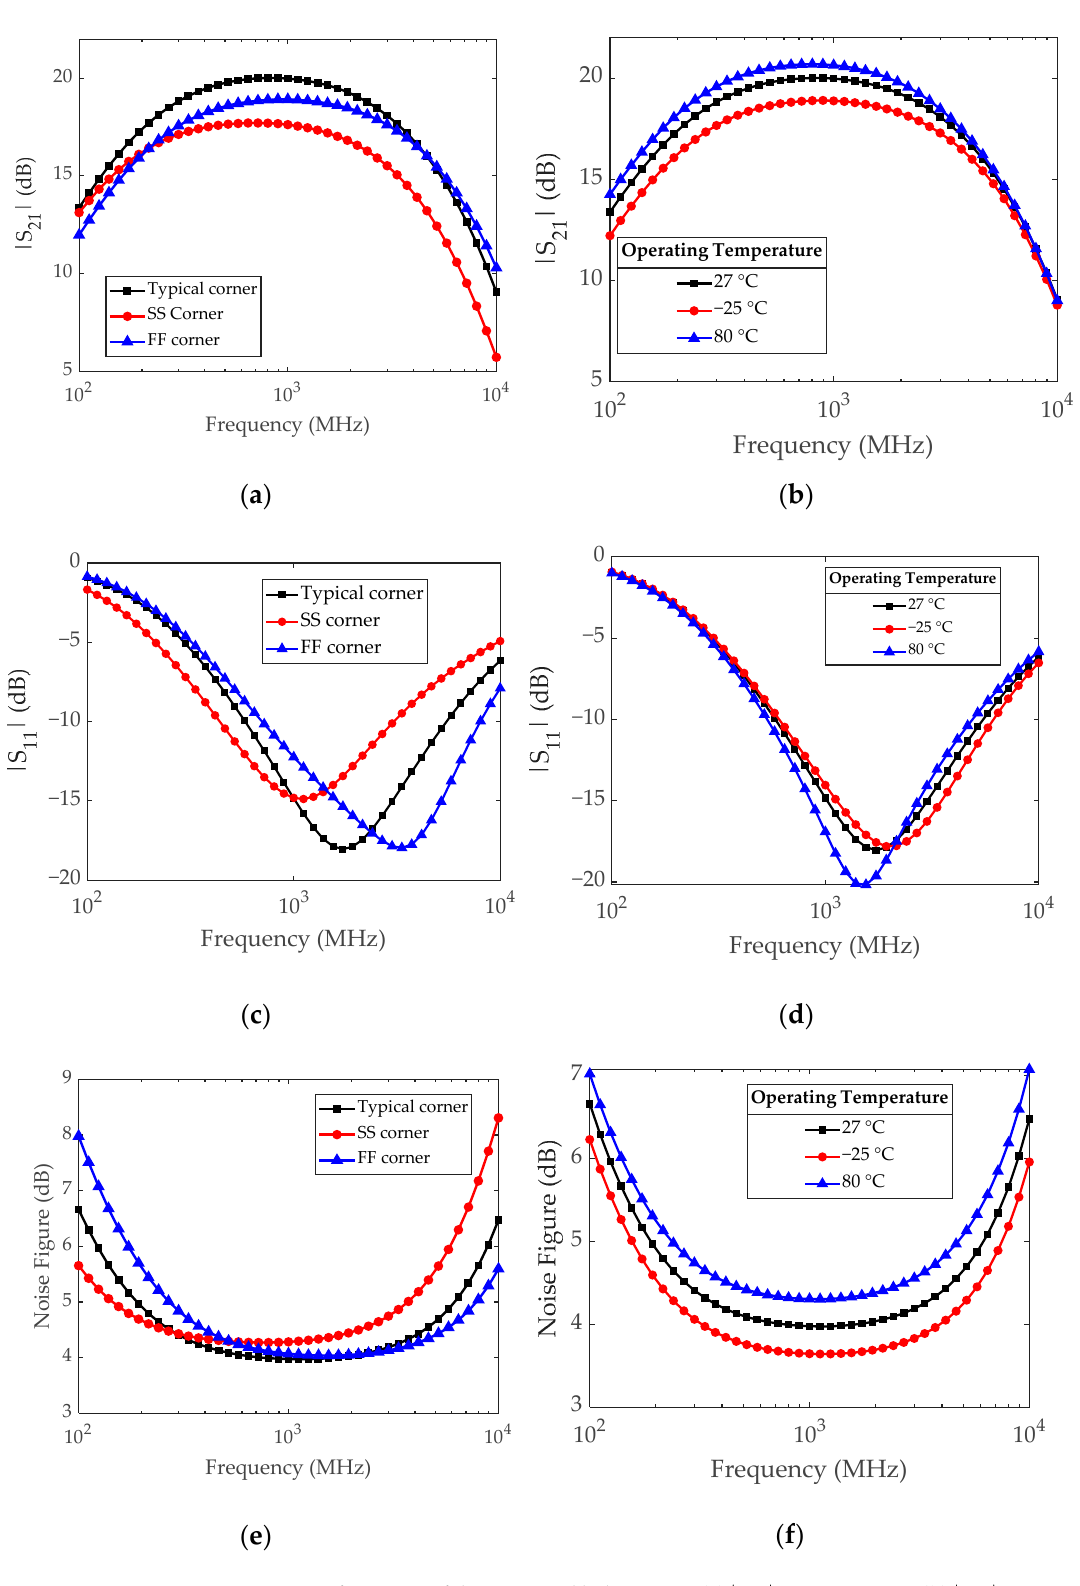
Figure 8. Performance of the proposed balun-LNA: ( a ) | S 21 | across corners, ( b ) | S 21 | across temperatures, ( c ) | S 11 | across corners, ( d ) | S 11 | across temperatures, ( e ) NF across corners, ( f ) NF across temperatures. Input matching (Figure 8c,d) of the proposed LNA shows robustness against tempera- ture variations. At − 10 dB the point of low temperature shifted to 0.5–5.2 GHz, while